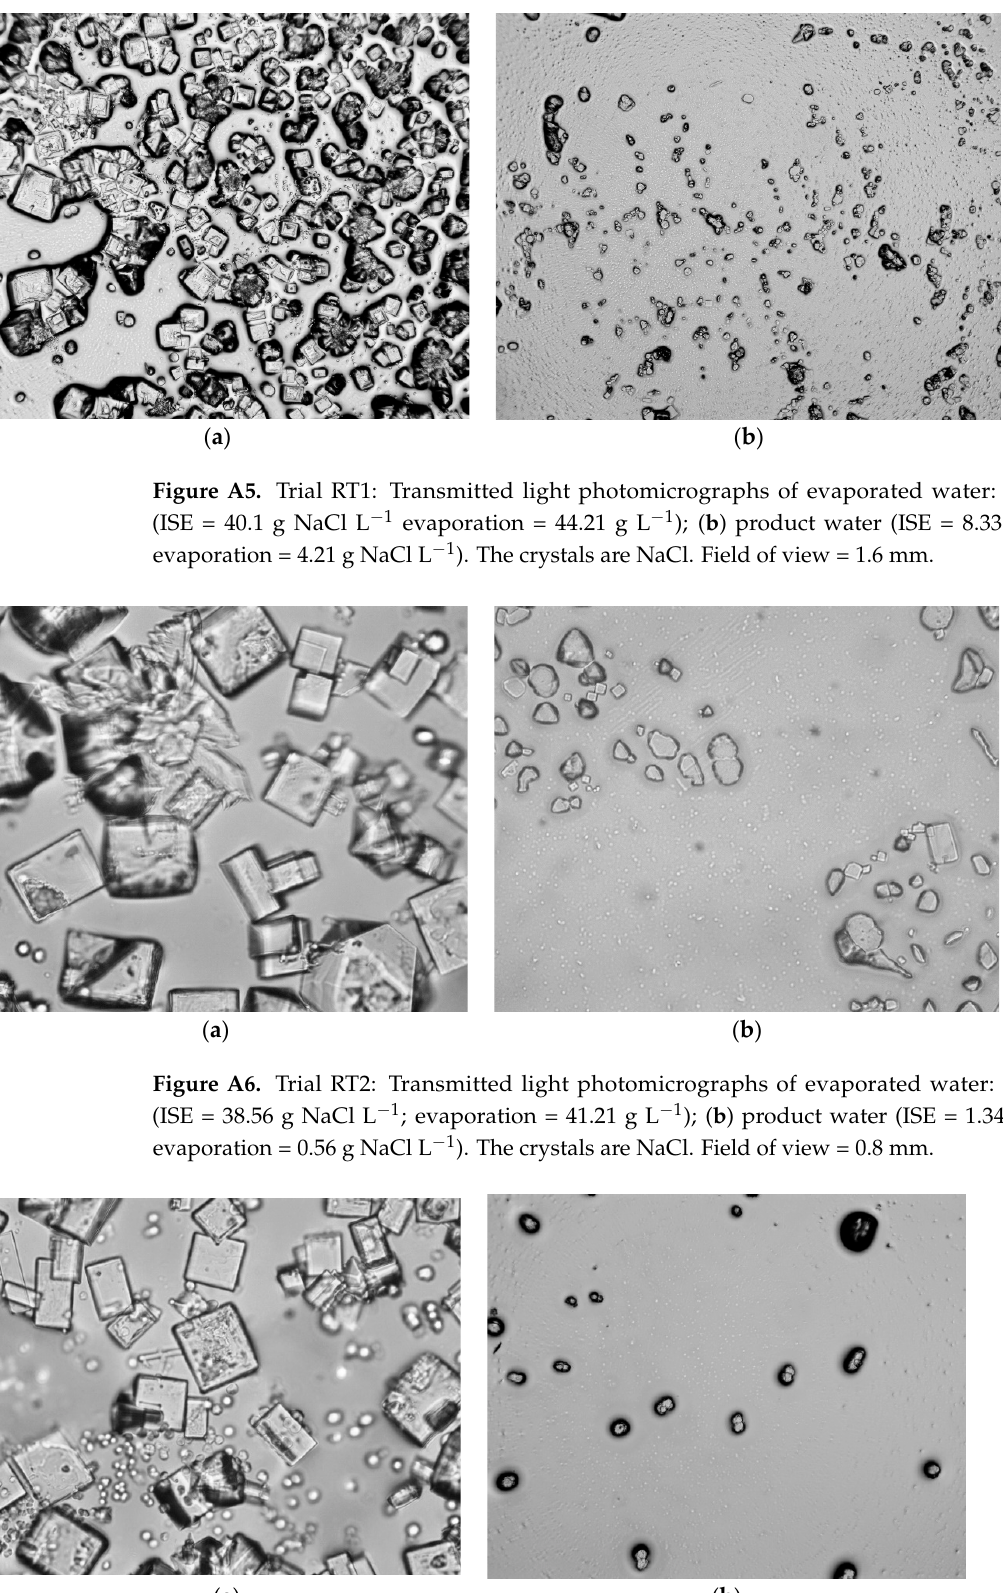
Figure A7. Trial RT3: Transmitted light photomicrographs of evaporated water: ( a ) Seawater (ISE = 36.54 g NaCl L − 1 ; evaporation = 41.35 g L − 1 ); ( b ) product water (after 71 days) (ISE = 4.90 g NaCl L − 1 ; evaporation = 0.72 g NaCl L − 1 ). The crystals are NaCl. Field of view = 0.8 mm.